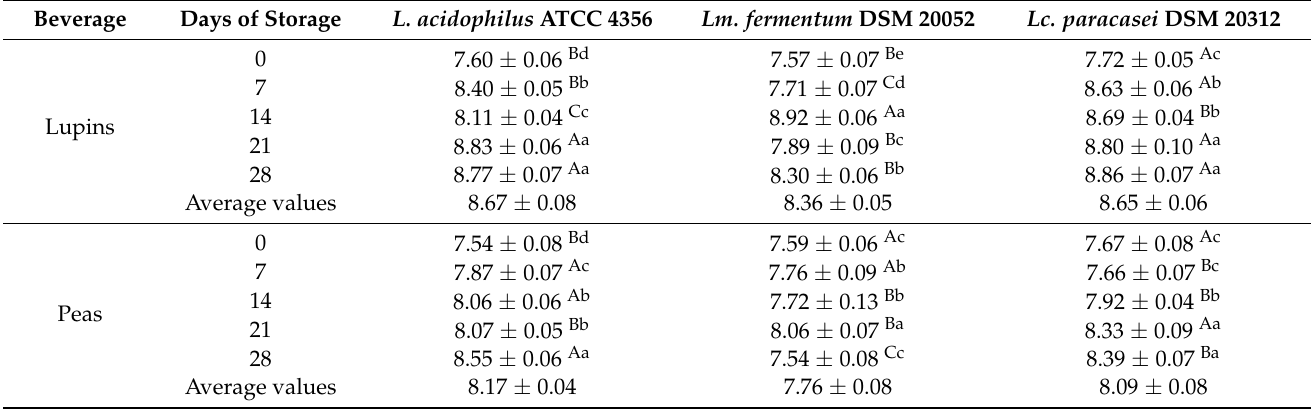
Table 6. Cell density (log cfu mL − 1 ) of selected lactobacilli in legume-based beverages during 28 days of storage at 4 ◦